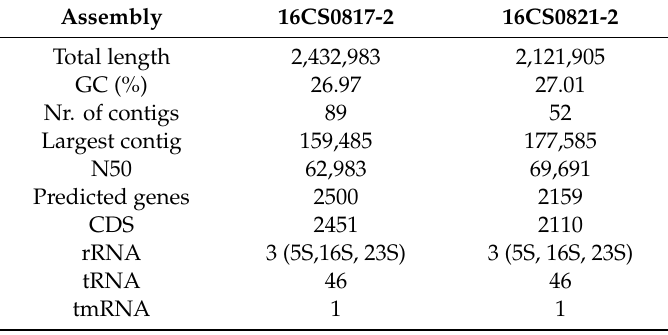
Table 2. Summary of the assembly results of the A. butzleri strains 16CS0817-2 and 16CS0821-2 using SPAdes (v. 3.12.0), Quast (v. 4.3) and Prokka (v.